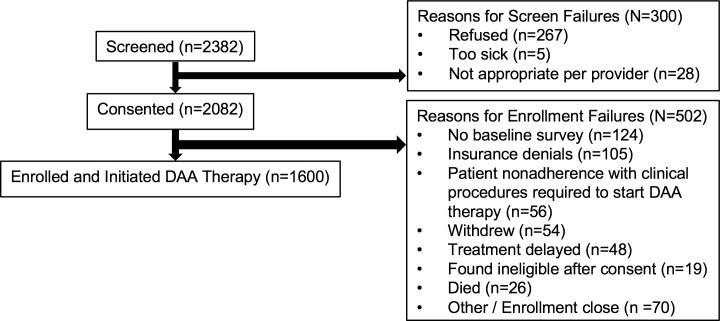
Study flowchart.